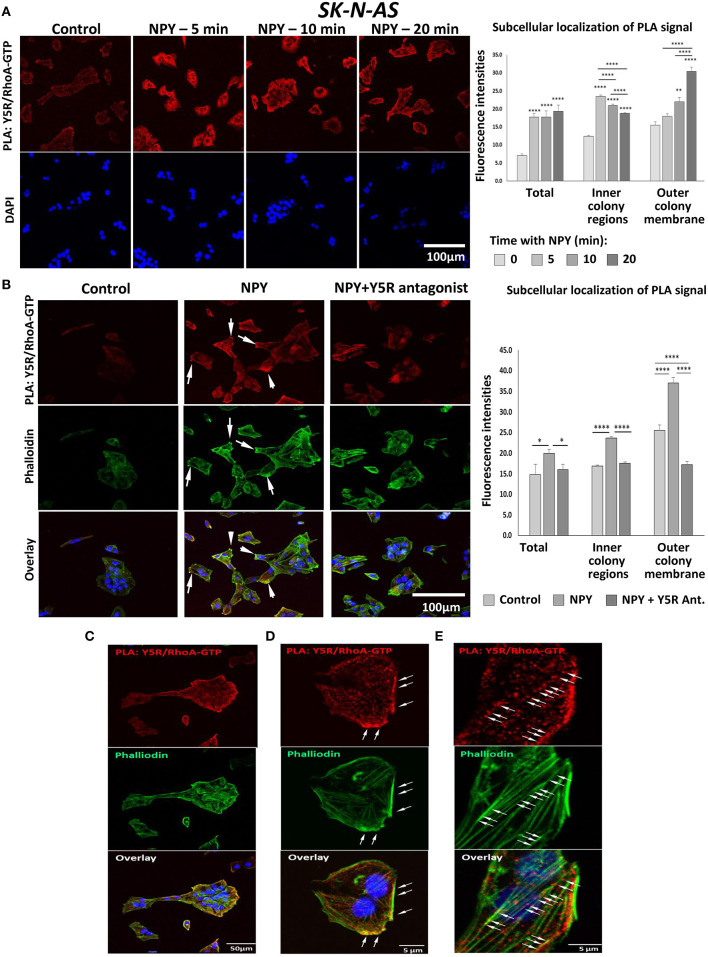
In situ proximity ligation assay (PLA) reveals interactions between Y5R and RhoA-GTP. PLA performed in SK-N-AS cells with anti-Y5R and anti-RhoA-GTP antibodies. (A) Representative confocal microscopy images of PLA in SK-N-AS cells treated with NPY (10−8 M) for 5, 10, and 20 min. Red dots represent interactions between Y5R and RhoA-GTP. The graph depicts quantification of fluorescence intensities for the total PLA signal or the signal located inside of the cell colonies and near their outer membranes in SK-N-AS cells treated with NPY. (B) PLA (red) and phalloidin staining (green) in SK-N-AS cells treated with NPY (10−8 M) for 20 min, with or without Y5R antagonist (10−6 M) pre-treatment for 30 min. White arrows indicate leading edges of the neuroblastoma (NB) cells. The graph represents a quantification of fluorescence intensity of the PLA signal—total or located inside of cell colonies and near their outer membranes in SK-N-AS cells treated with NPY and Y5R antagonist as above. (A,B) *p < 0.05, **p < 0.01, ****p < 0.0001 vs. non-treated control or ****p < 0.0001 as indicated, by one-way ANOVA followed by Tukey's test; mean ± SEM, n = 11–21 per condition. (C) Co-localization of the PLA signal (red) with F-actin (green) on the outer membranes of cells within the colony with migratory phenotype. (D) PLA signal in the area rich in F-actin near the outer plasma membrane. (E) Localization of the PLA signal along F-actin fibers.